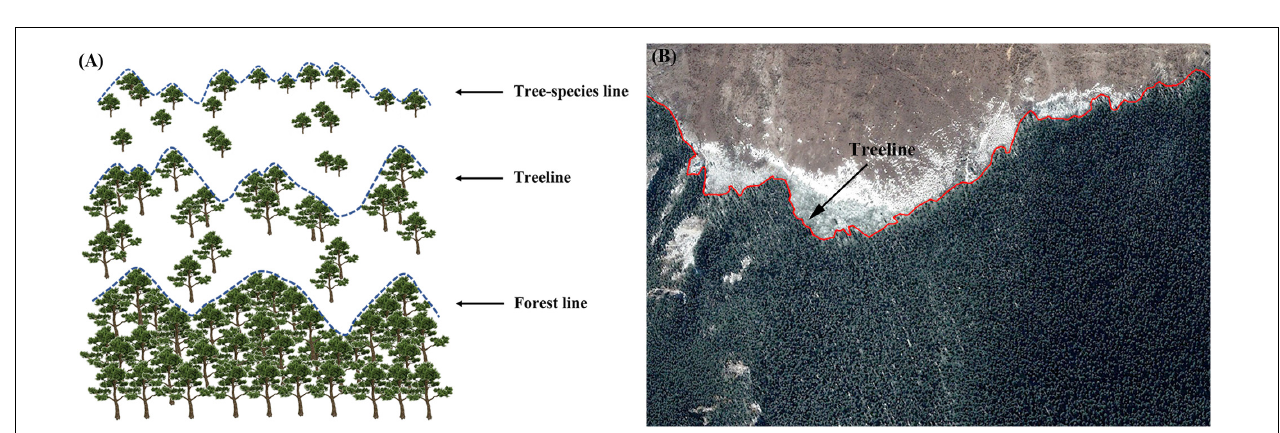
FIGURE 1 | Location of the studied treeline sites in Hengduan Mountains area. BSLL, Boshulaling Mountain; ML, Meili Snow Mountain; BM, Baima Snow Mountain; GZ, Gezong Snow Mountain; HB, Haba Snow Mountain; GG, Gongga Mountain; SS, Sanshen Mountain; YL, Yulong Snow Mountain; JP, Jinping Mountain.